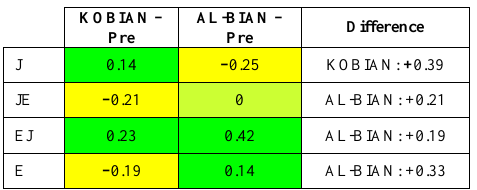
Table 3. Percentage of cases of greeting interaction and of long reaction time in the answer.